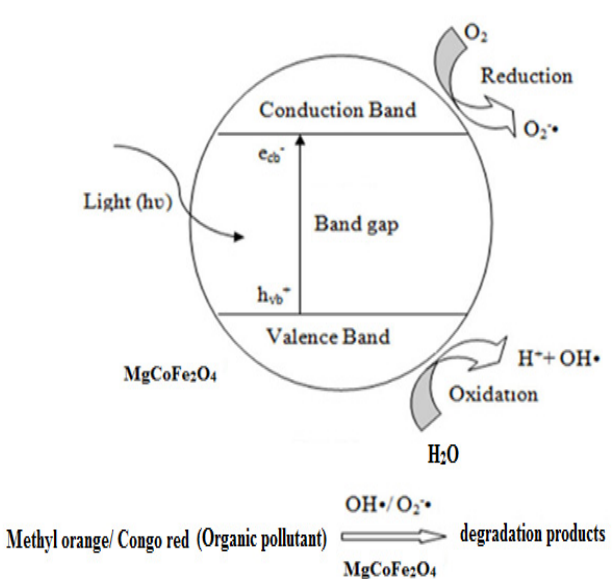
Fig. 3. Setup for decolorization of organic dyes and basics of